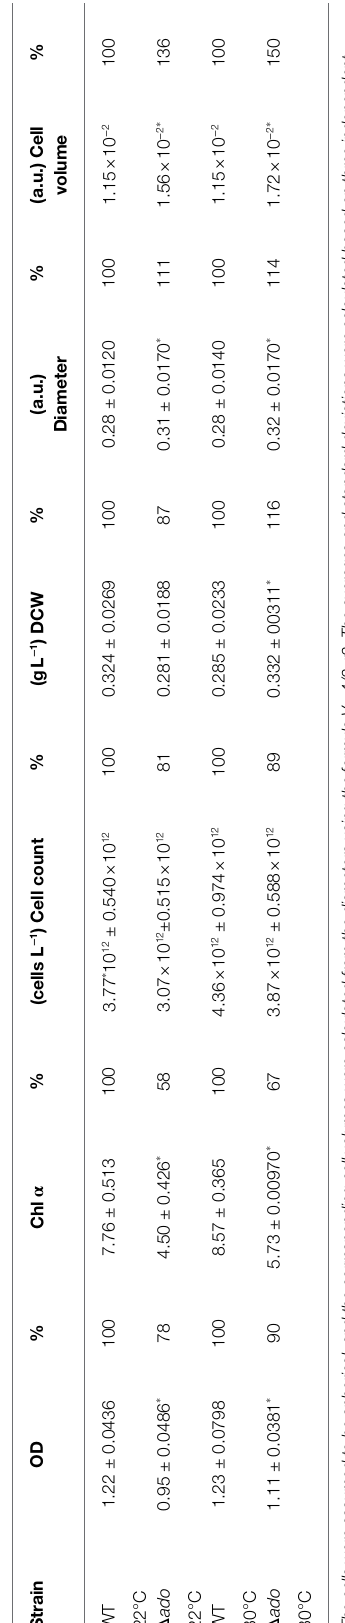
( Supplementary Figures S11E vs. I, Q vs. U ). In accordance, there were no signs of donor side limitation [Y(ND)], supporting the view that the electron flux from PSII was not restricting the system capacity in either of the strains ( Supplementary Figures S11F,J,R,V